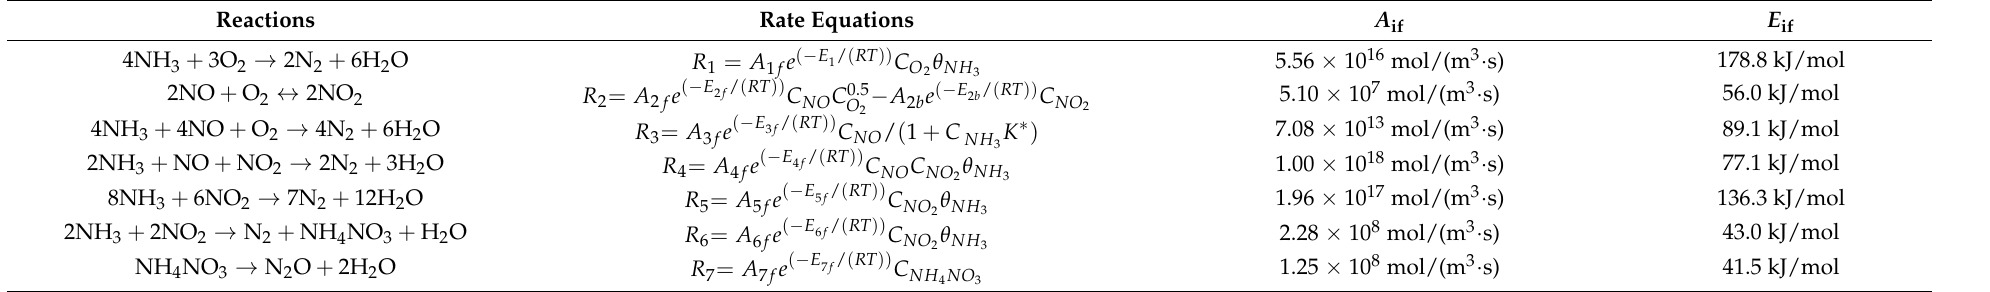
Table 5. Kinetic model with H 2 O in feed gases